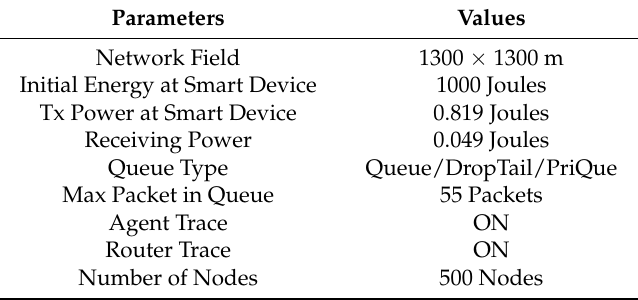
Table 5 . Simulation Parameters. Table 5. Simulation Parameters.